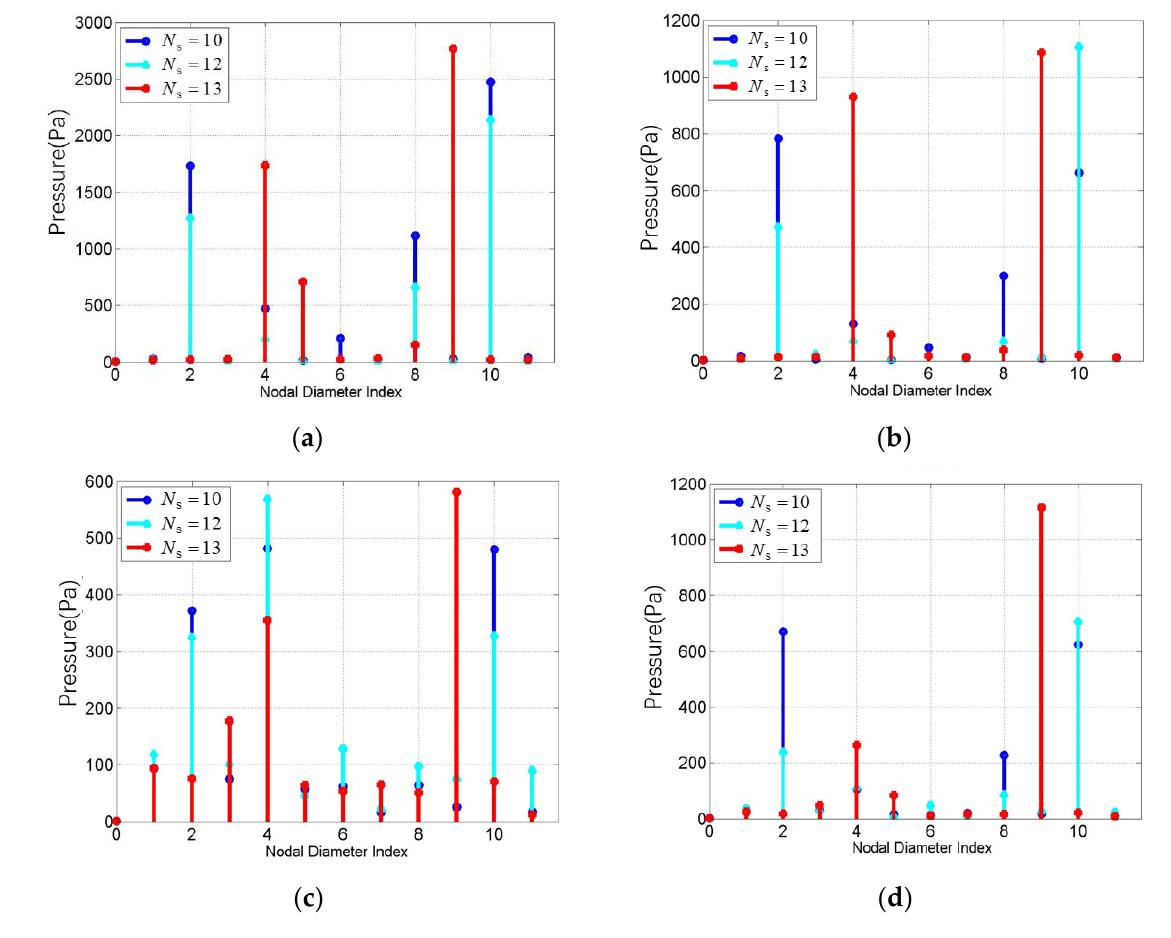
Figure 9. Circumferential wave spectrum of monitoring point pressure on rotors with different stator blade numbers at: ( a ) the leading edge; ( b ) the basin; ( c ) the back; and ( d ) the trailing edge.